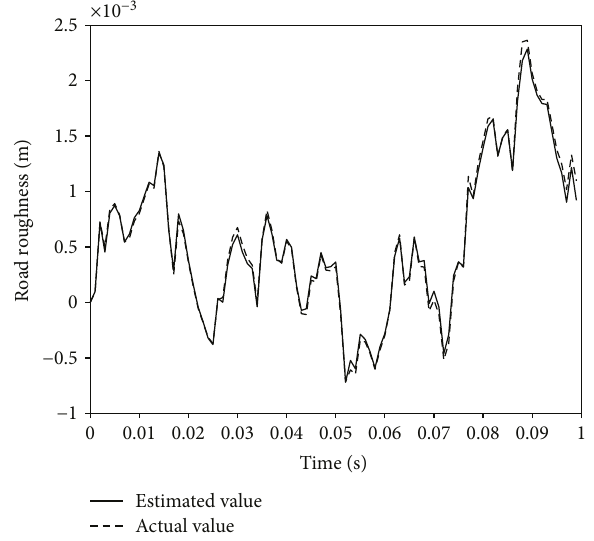
Figure 6: Road roughness estimation results with features in Experiment 4.